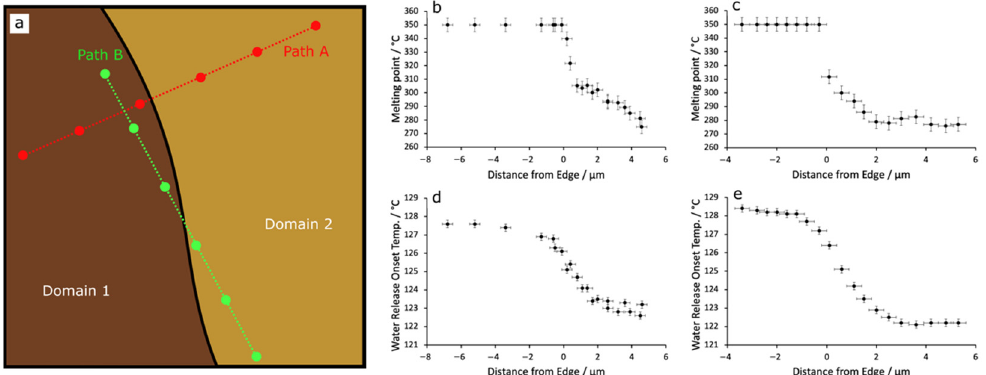
Figure A9. NanoTA analysis of PPB boundaries at high resolution showing ( a ) a schematic of two-line profile paths: path A (red) normal to the boundary, and path B (green) at a grazing angle, which achieves higher spatial resolution with respect to distance from the edge for a fixed separation of sampling points. Melting point transitions ( b , c ) and water release onset temperatures ( d , e ) for two different domain boundaries along path B are shown.